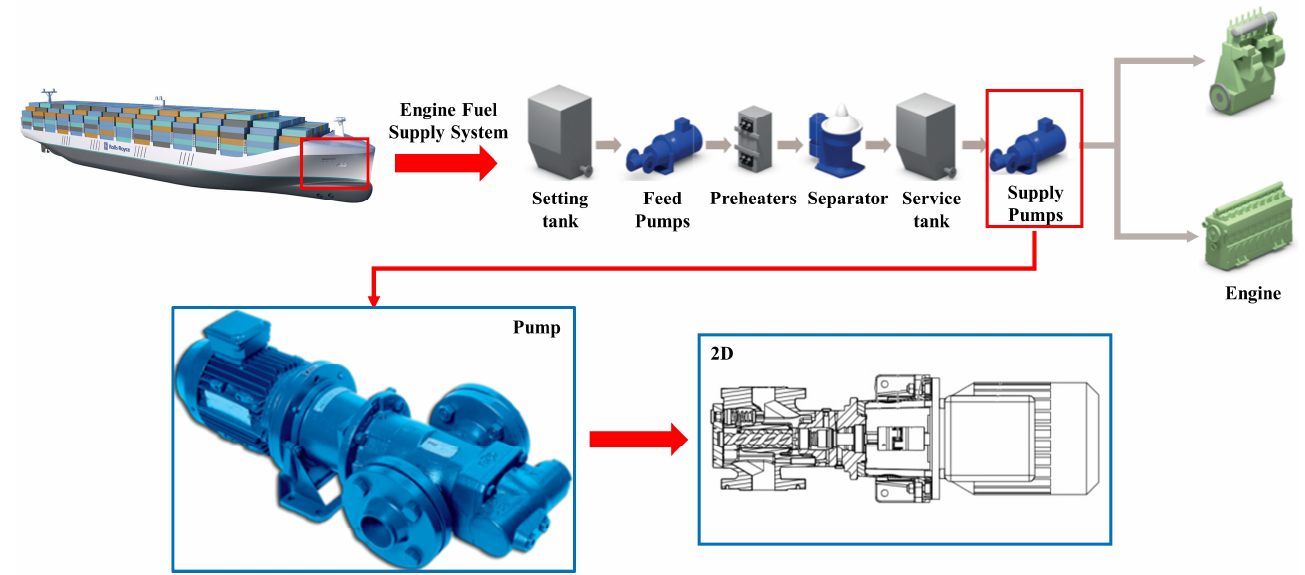
Figure 1. The 3-axis screw pump of target device. Reprinted/adapted with permission from Refs. [6,9].